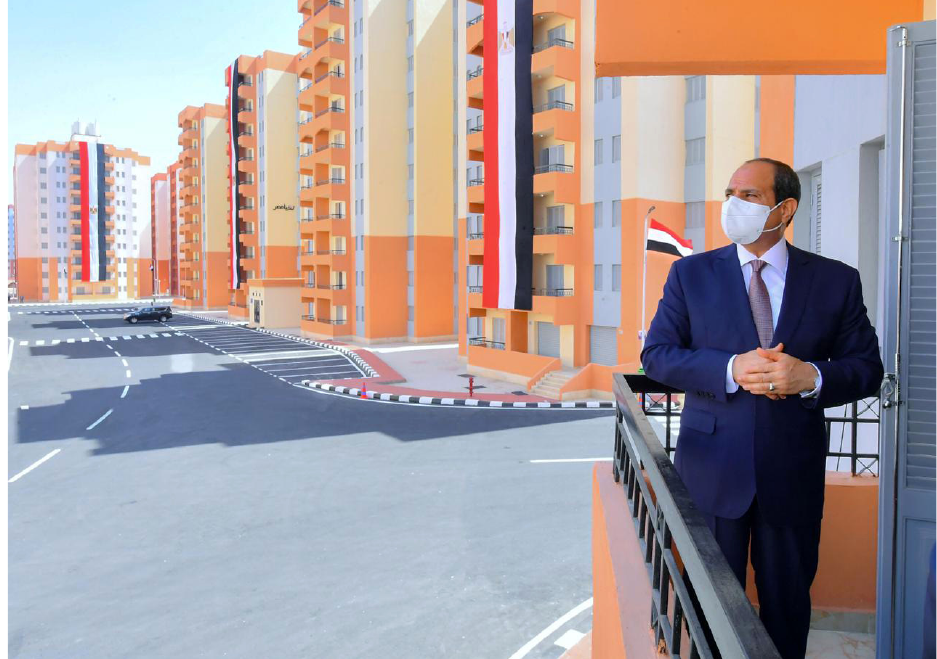
Figure 1. Media coverage for the inauguration of Al‐Asmarat. Source: Sayed